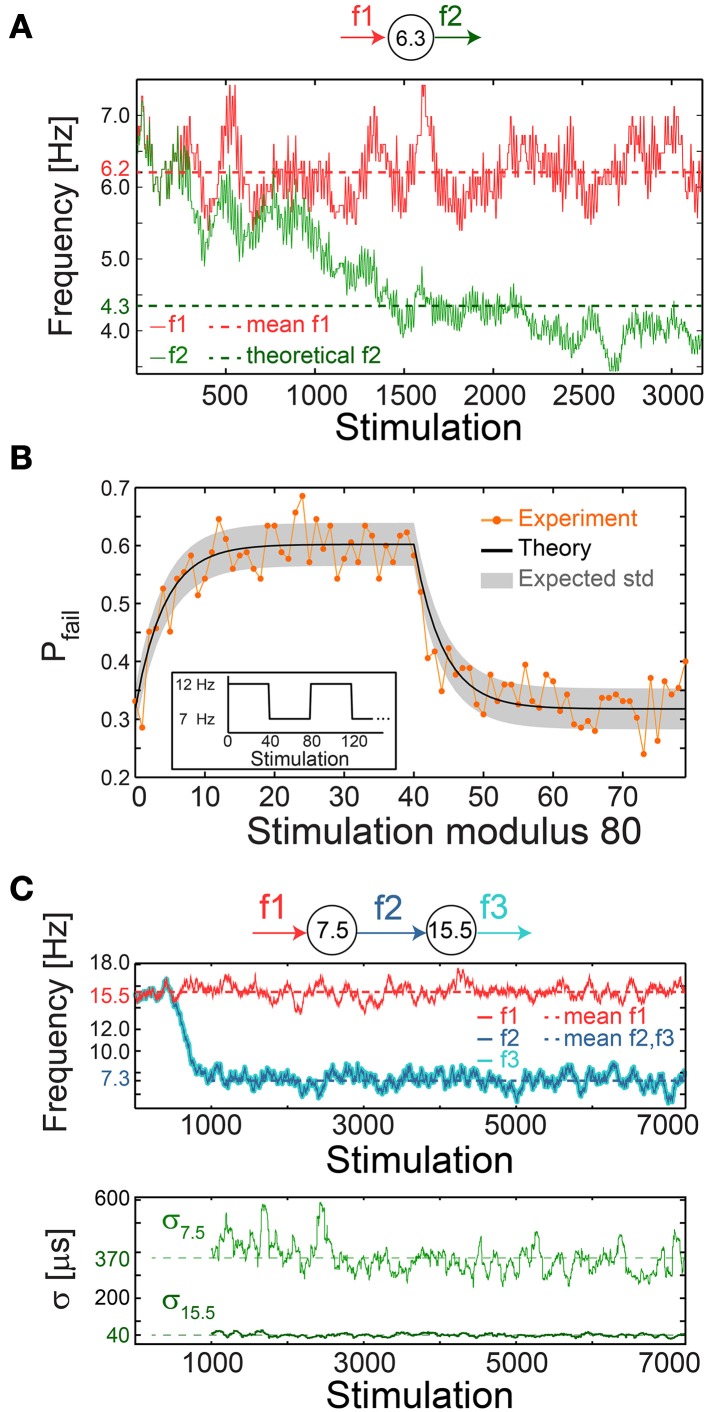
Neuronal impedance mechanism on a chain level leading to low firing rates. (A) Schematic (top) of a cultured neuron with fC = 6.3 Hz and its stimulation/firing frequencies, f1/f2, respectively. Stimulation frequency (red) and firing frequency (green) smoothed using 100 Stimulation sliding window of a neuron stimulated with alternating time-lags, 20 and 300 ms, equal on the average to ~τC, each time-lag repeats 5 to 10 times before switching. The averaged f1 = 6.2 Hz (red dashed-line) and the theoretically predicted f2 = 4.3 ms (green dashed-line) are shown for comparison. The resulting firing frequency of the cultured neuron is ~4 Hz (green full line), substantially lower than its fC, and is close to the predicted f2 following ISI = 0.5(160 + 300) = 230 ms. (B) A cultured neuron with fC ~5.5 Hz was stimulated periodically, 40 times at 12 Hz and 40 times at 7 Hz (inset). The probability of a response failure, Pfail(i), i, …,79 (orange dots), measured over 200 recurrences, fitted with optimized α = 1.1 following equation (3) (black line) and the expected standard deviation (Pfail(i)(1−Pfail(i)))/200 (gray area). The experimentally observed probabilities are similar to the predicted values under a fixed stimulation frequency, Pfail = (τC − τ)/τC = 1-fC/f, resulting in 1-(5.5/12)~0.54 for 12 Hz and 1-(5.5/7)~0.21 for 7 Hz. (C) Schematic (top) of a chain of two cultured neurons with fC = 7.5 and 15.5 Hz, their stimulation and firing frequencies. Top panel: the firing frequency of the first/second neuron (dark/light blue), obtained when the first neuron is stimulated with τ taken randomly from U (20, 110) ms (red full-line), 15.5 Hz on the average (red dashed-line). This results in f2 = f3 with an average of ~7.3 Hz (blue dashed-line). Bottom panel: σ for the first/second neuron (light/dark green). Curves were smoothed using 100 Stimulation sliding window.